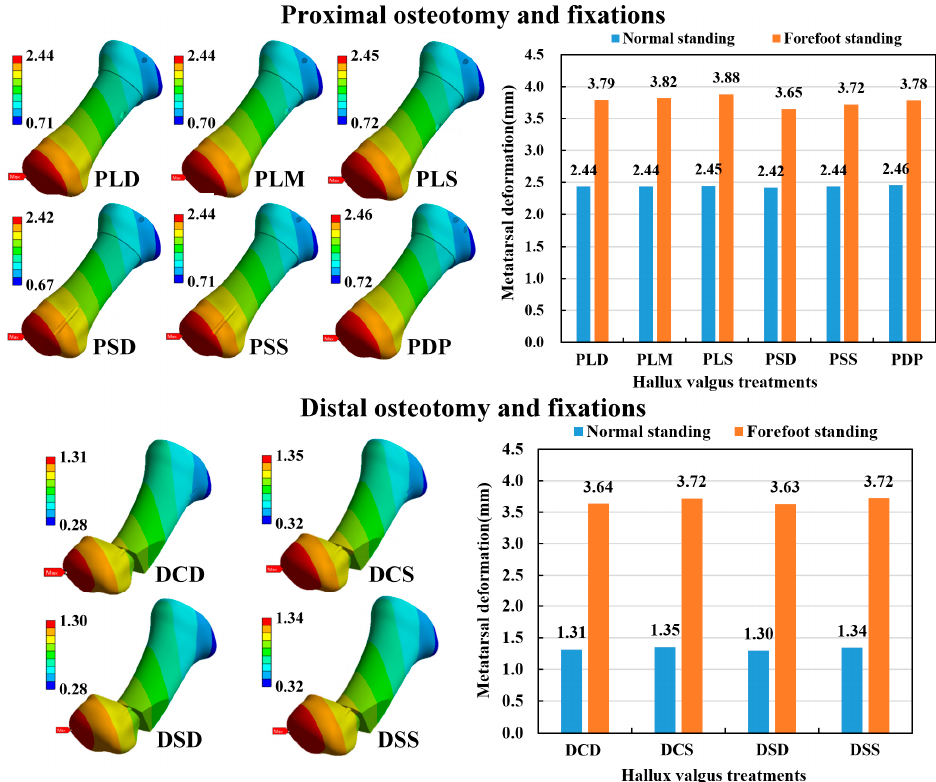
Figure 6. The displacement distribution of the numerical models and the results of the metatarsal deformation.